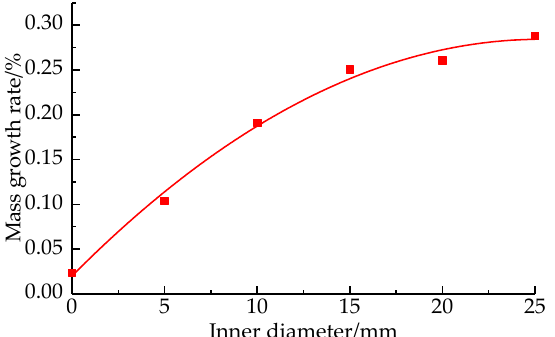
Figure 3. Mass growth rate changes with annular diameter change.